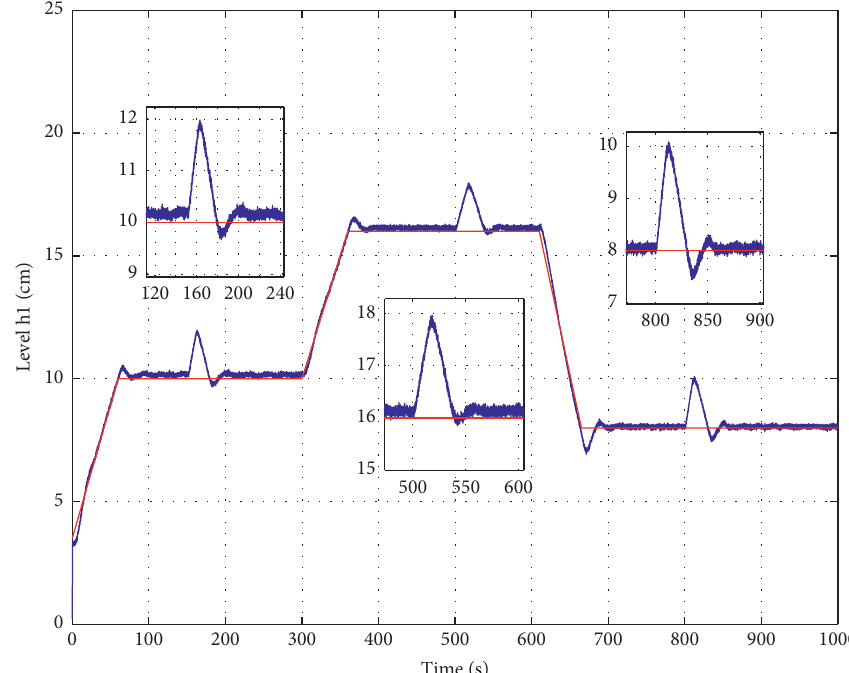
Figure 7: Experiment result for NTSMC tracking and its impact on external disturbance.